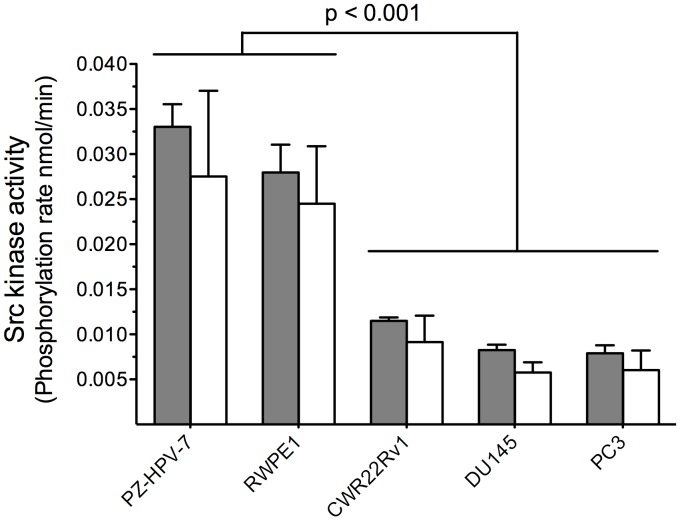
Src kinase activity in non-invasive (PZ-HPV-7, RWPE1), invasive (DU145, PC3), and androgen-independent (CWR22Rv1) cell lines.Grey bars are phosphorylation rates of peptide 1 by whole cell lysates (normalized by total protein extract amount). White bars are phosphorylation rates by cell lysates due to Src kinase alone after subtracting non-Src background phosphorylation of 1. Comparison between non-cancer (PZ-HPV-7, RPWE1) and aggressive cancer cell lines (CWR22Rv1, DU145, PC3) showed significant lowered levels of Src kinase activity associated with the later (p<0.001). All experiments were performed at least in triplicate. Error bars are SEM.